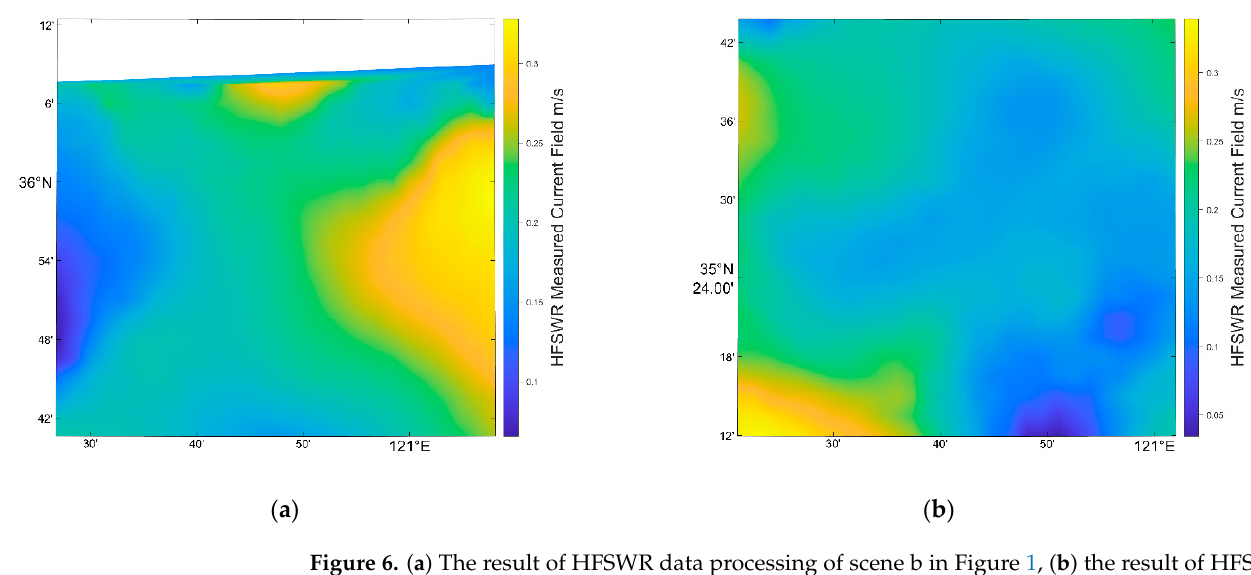
Figure 6 . ( a ) The result of HFSWR data processing of scene b in figure 1, ( b ) the result of Figure 6. ( a ) The result of HFSWR data processing of scene b in Figure 1, ( b ) the result of HFSWR HFSWR data processing of scene c in figure 1. data processing of scene c in Figure 1.